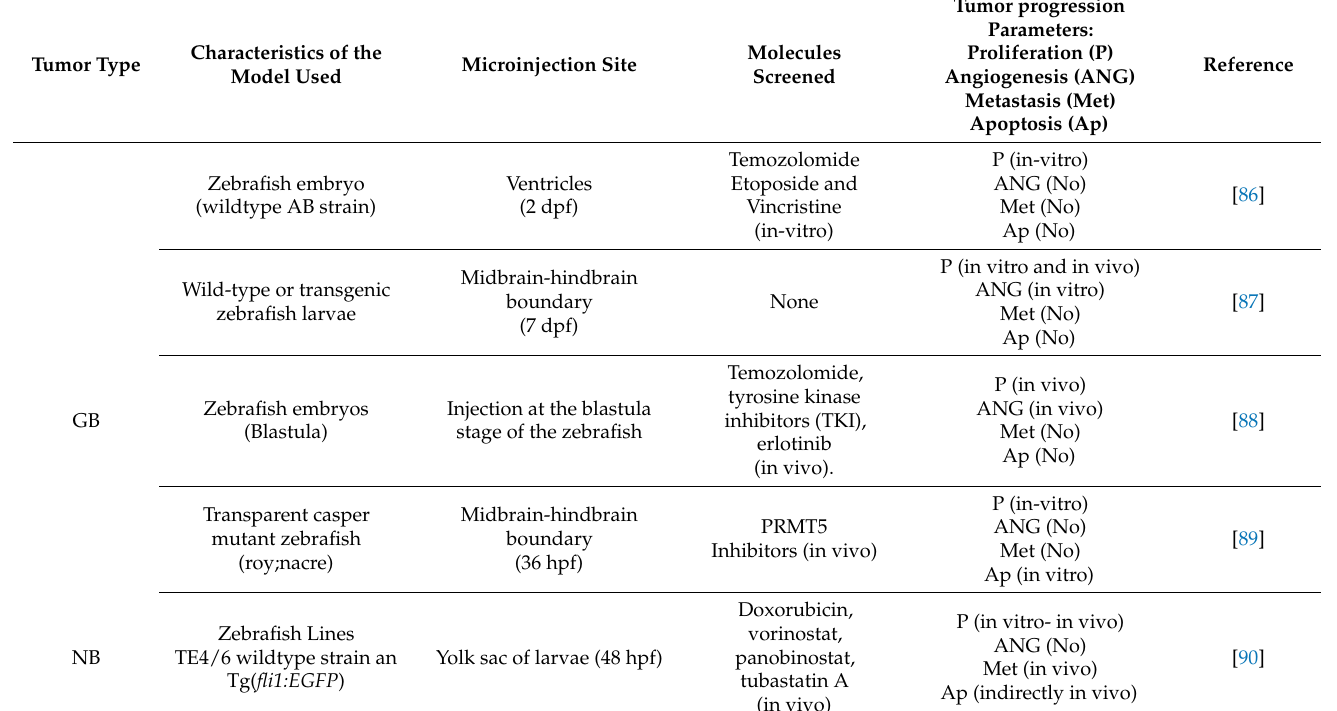
Table 1. Summary of articles with patient-derived xenotransplant of CNS neoplasms in zebrafish.